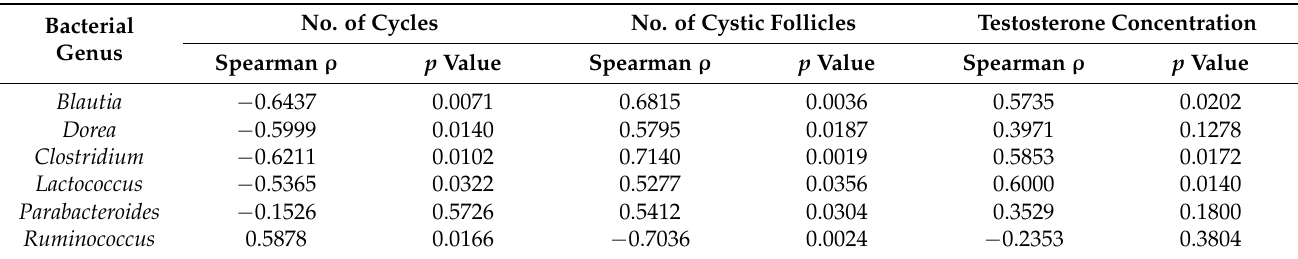
Table 3. Some correlations between the relative abundance of bacteria and menstrual irregularity (number of cycles during the diet treatment period), polycystic ovaries (number of cystic follicles) and hyperandrogenism (testosterone